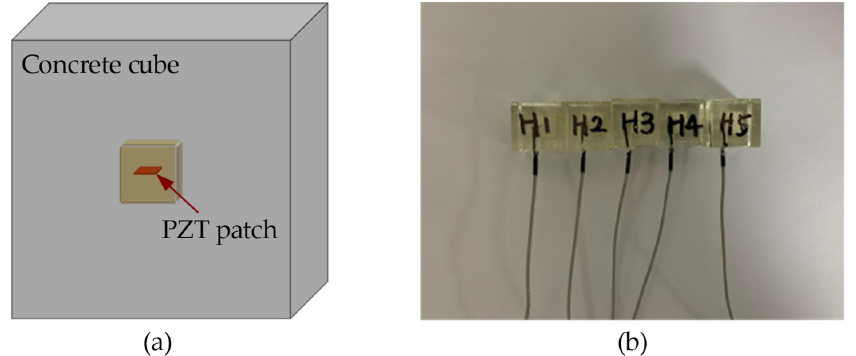
Figure 3. ( a ) Schematic layout of a cubic concrete specimen embedded with a PZT-based sensor; ( b ) fabricated PZT sensors packed with epoxy blocks.